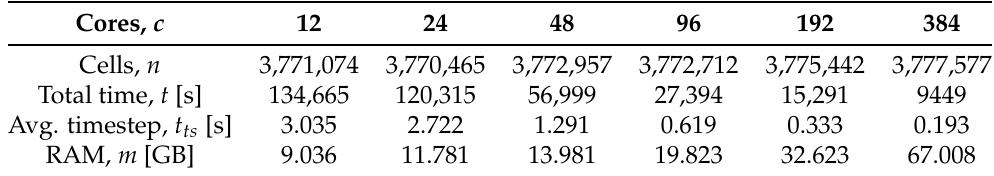
Table A4. Scalability and performance for AMR approach when the grid size is similar to the fine grid. Assessment is made for the k − ω TNT model. Refinement frequency is set to 1000 timesteps. Load balancing is performed when the imbalance reaches 10%. Presented values are three-run averages.